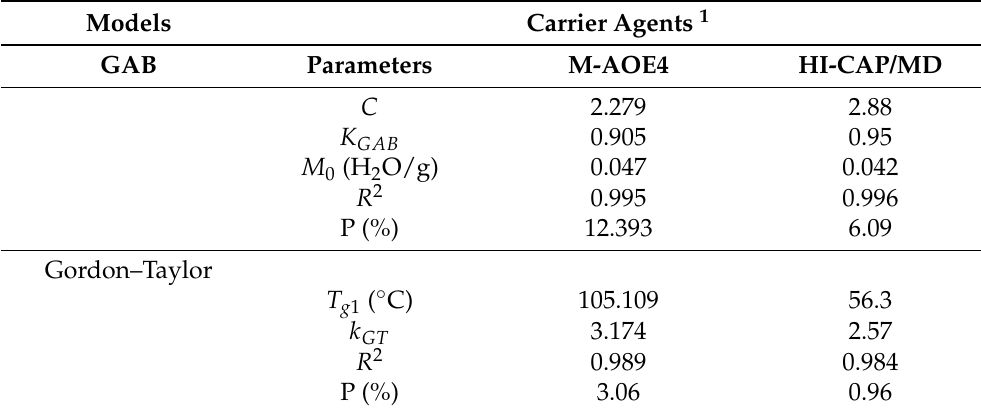
Table 5. Estimated parameters for selected sorption isotherms models, and prediction of T g by using Gordon–Taylor